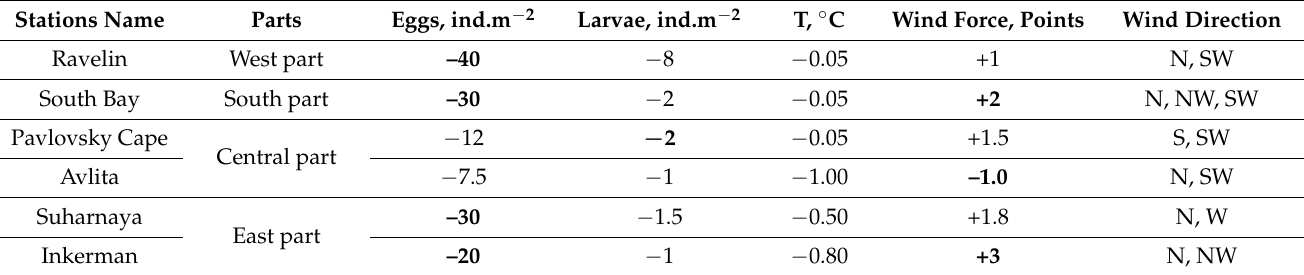
Table 2. Increments of intra-decadal trends in the dynamics of ichthyoplankton abundance and